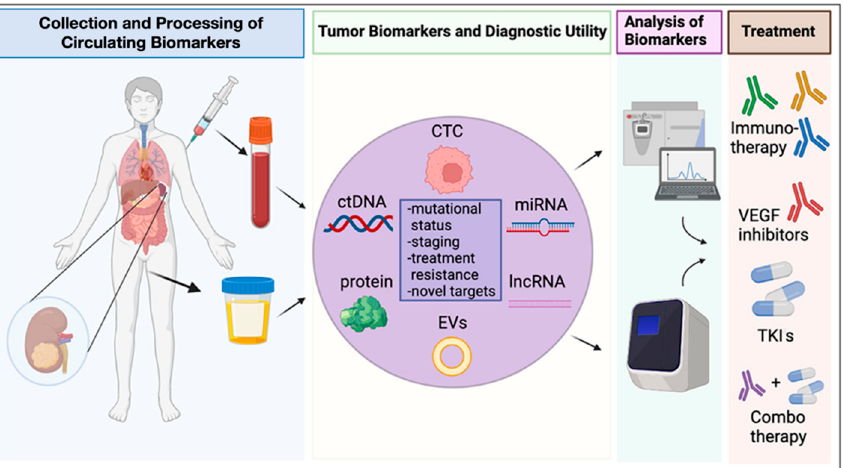
Figure 1. Circulating Biomarkers. Circulating biomarkers can be obtained from biological fluids such as blood and urine. These include circulating tumor cells (CTC), cell-free DNA (cfDNA), circulating tumor DNA (ctDNA), microRNA (miRNA), long-noncoding RNA (lncRNA), circulating proteins, and extracellular vesicles (EVs) (lipids complexed with DNA, RNA, or protein). Matching biomarker profiles with stage- and treatment-resistance phenotypes may allow tailored therapy with immunotherapy, vascular endothelial growth factor (VEGF) inhibitors, tyrosine kinase inhibitors (TKIs), or combinations thereof.